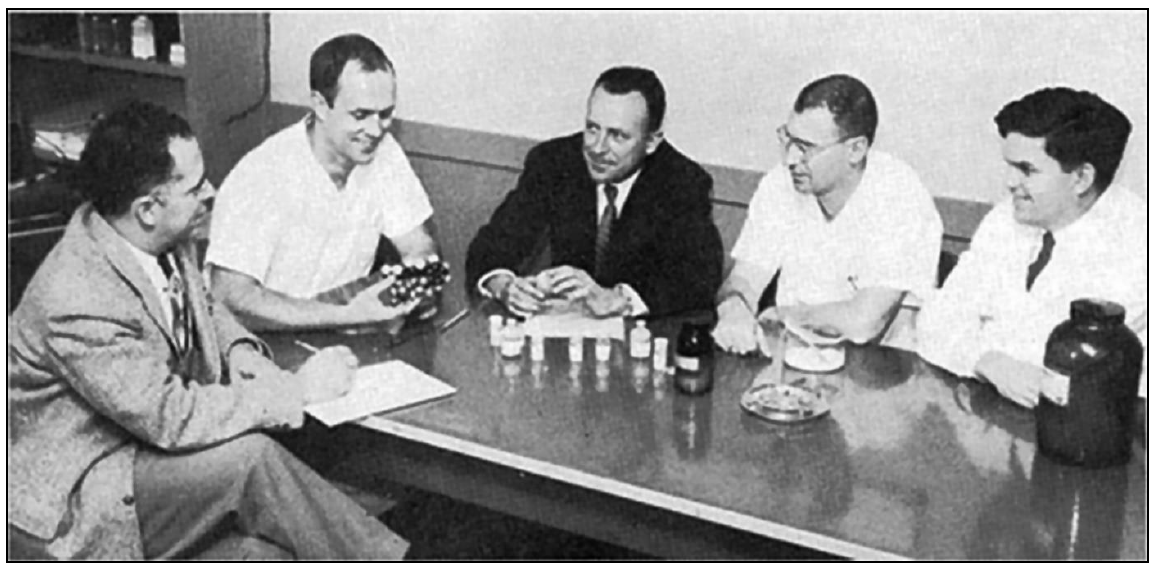
Figure 11. The Chemists. Pfizer Research in Brooklyn, NY. Members of the tetracycline structure determination and synthesis team (left to right): Frederick Pilgrim, Lloyd Conover, Karl Brunings, Phil Gordon, and Charles Stephens [167].